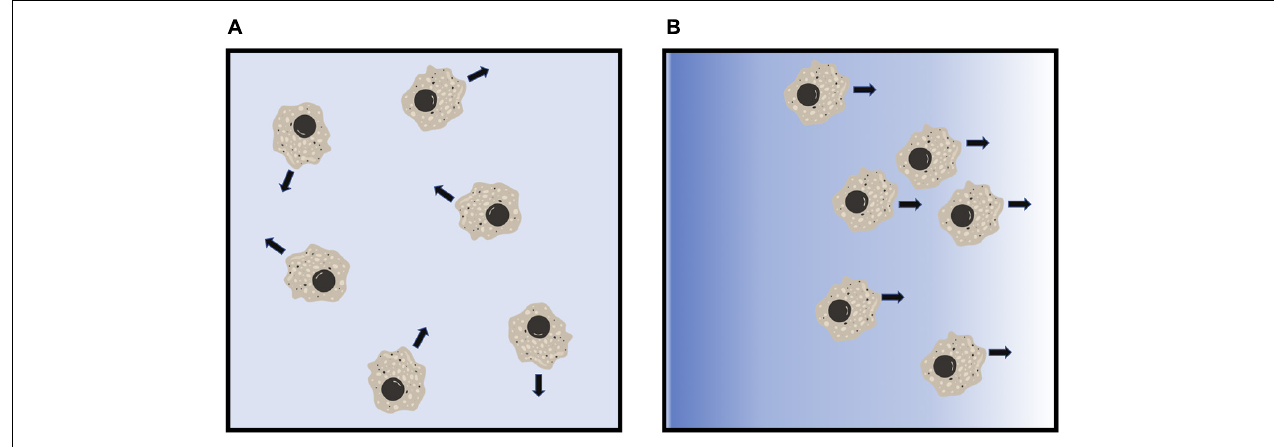
FIGURE 2 | Diagram of eukaryotic chemorepulsion. (A) In the absence of a gradient, cells extend pseudopods, and move, in random directions. (B) In a gradient of a chemorepellent (blue shading), cells move away from the higher concentration of the chemorepellent. Figures were created using BioRender.com.